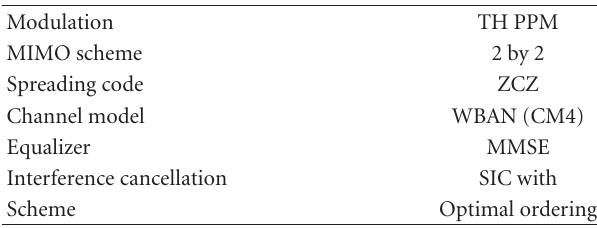
Table 3: Simulation parameters.